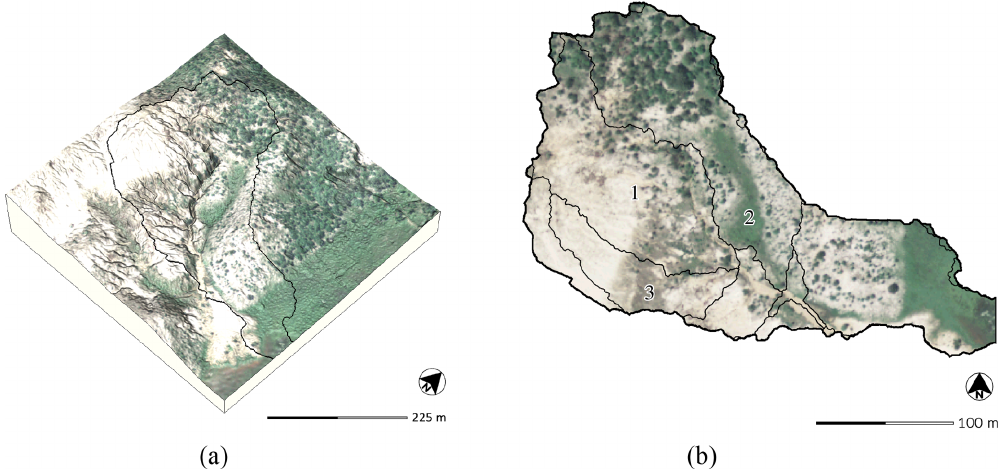
Figure 4. Subwatershed with 2014 orthoimagery (a) draped over the 2016 digital elevation model and (b) drainage areas with 2014 orthoim- agery, Patterson Branch, Fort Bragg, NC,